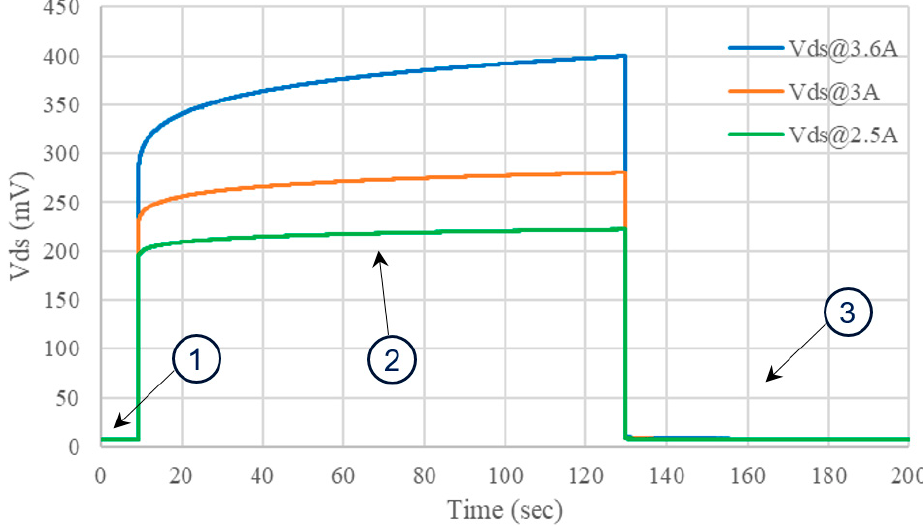
Figure 8. Trend of V ds.